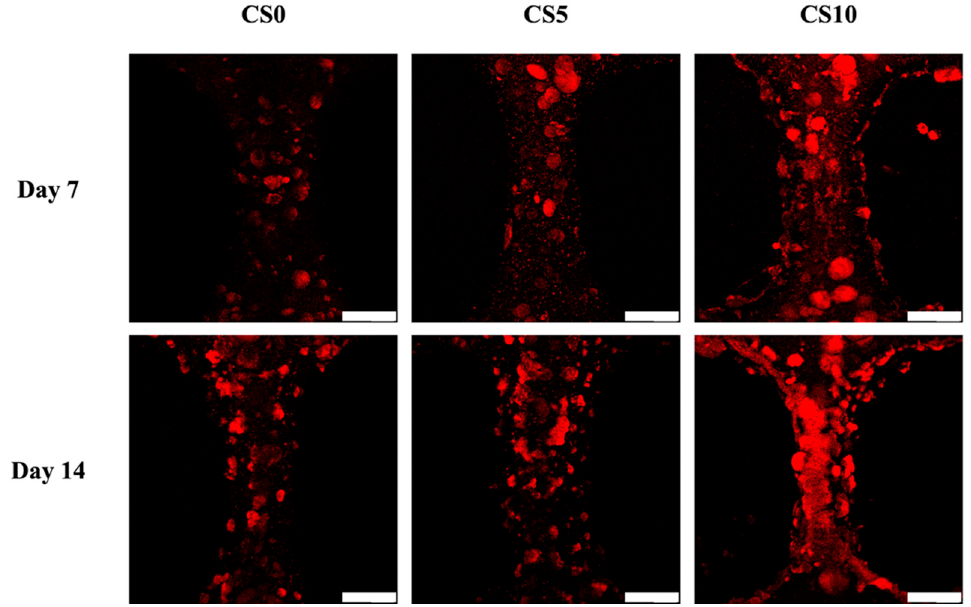
Figure 11. The fluorescent of Alizarin red S staining of hDPSCs-laden CS/GelMa scaffold and cultured for 7 and 14 days. The scale bar is 200 μ m.